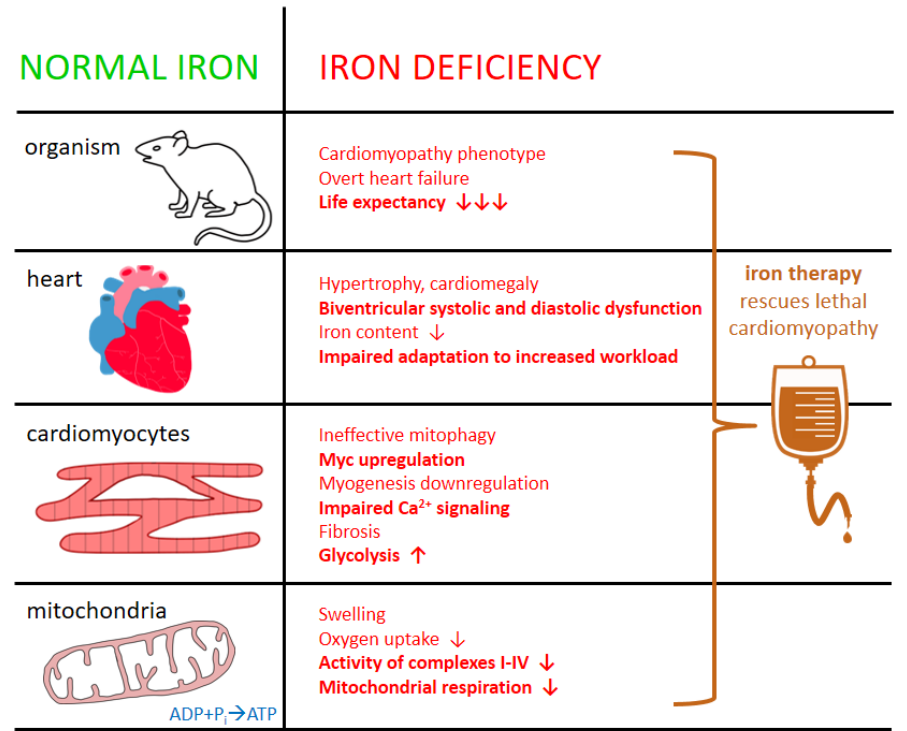
Figure 2. Detrimental effects of iron deficiency on the heart at various levels of tissue organization. For details and references — see Section 4.2.